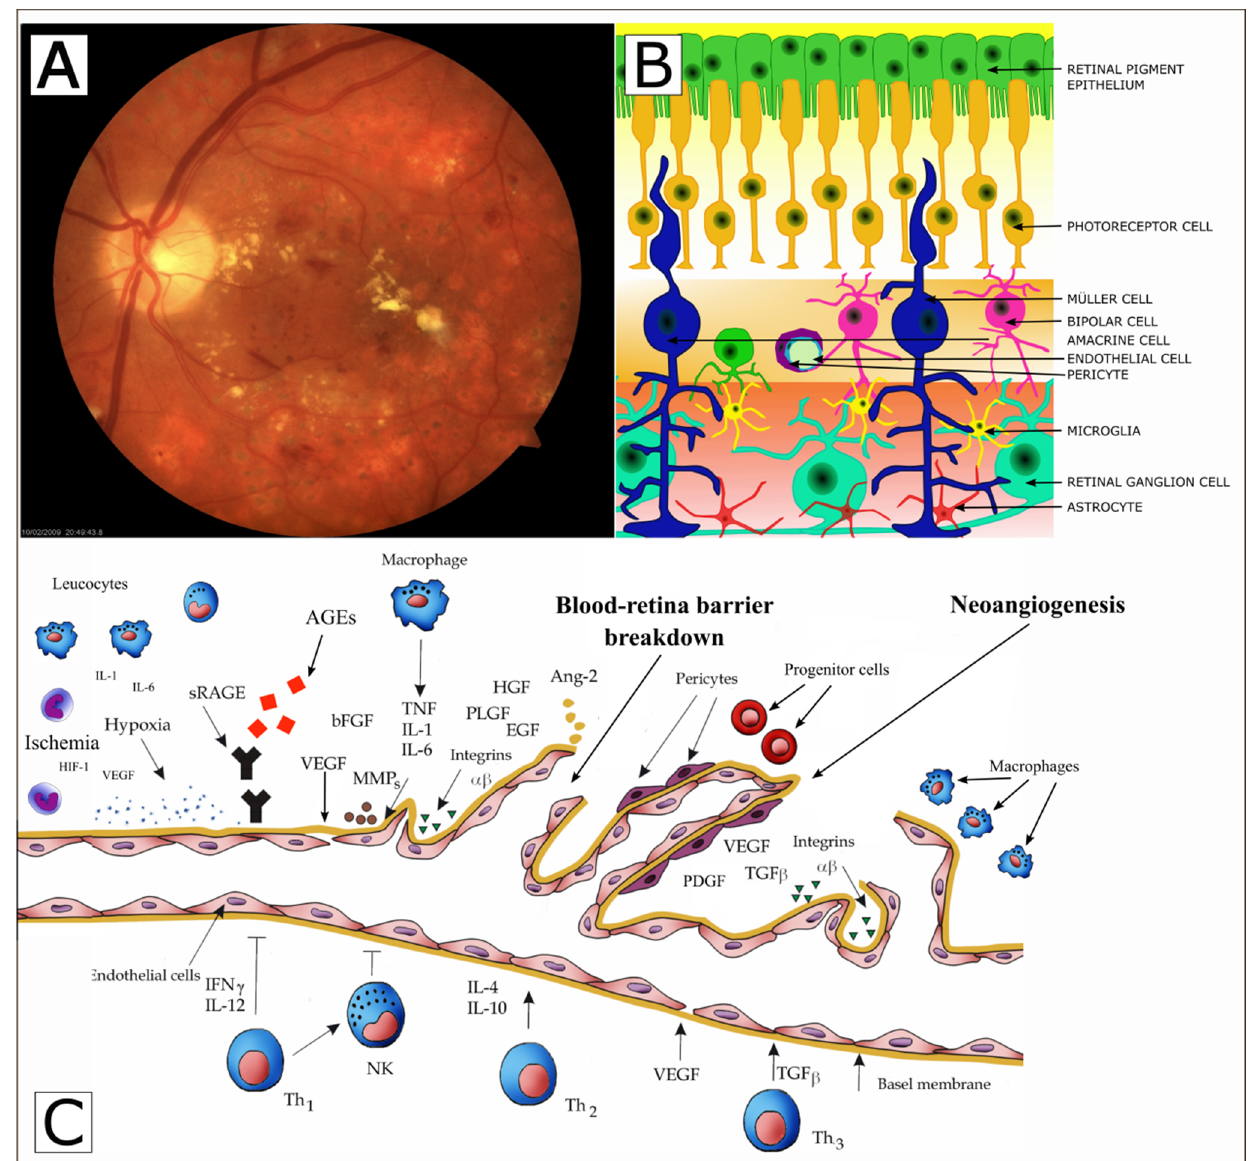
Figure 1. Possible mechanism of retinal vascular endothelial cell dysfunction and neuroretinal degeneration in diabetic patients. Fundus photos of eyes from diabetic retinopathy accompanied by macular oedema ( Panel A ), modified from [42]. The neurovascular unit of the retina (retinal ganglion cells, Müller cells, microglia, astrocytes, endothelial cells, pericytes, and other). ( Panel B ) , modified from [43]. The selected factors involved in the development and progression of diabetic retinopathy. AGEs—advanced glycation end products, RAGEs—receptor for advanced glycation end products, VEGF- vascular endothelial growth factor, IGF-I—insulin like growth factor, PLGF—placental growth factor, HGF—hepatocyte growth factor, PEDF pigment epithelium derived factor, bFGF—basic fibroblast growth factor, TGF-beta. transforming growth factor beta, MMPs—metalloproteinases PDGF-platelet-derived growth factor, EGF-Epidermal growth factor, Ang-2—Angiopoietin-2, ( Panel C ), modified from [42,43].